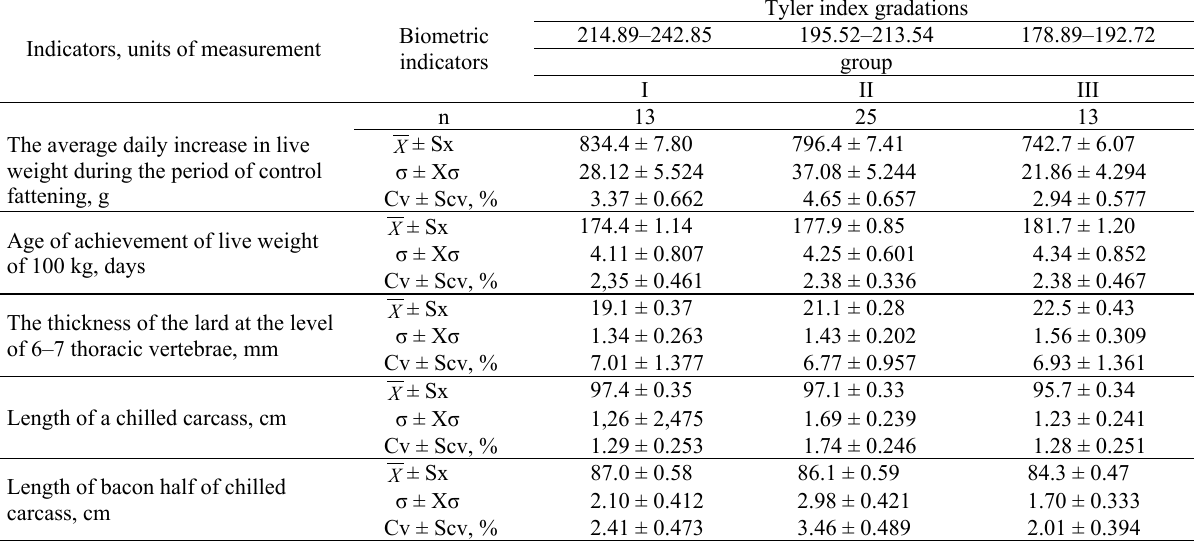
According to Tyler's index, the fattening and meat qualities of young pigs of Large White breed of different interbreed differ- entiation